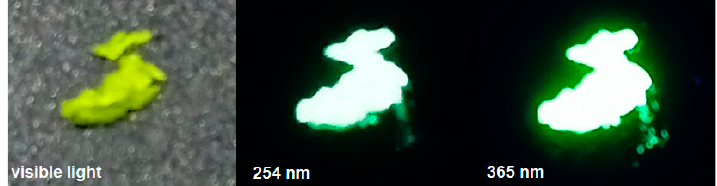
Figure 2. Solid state fluorescence of compound 1 .